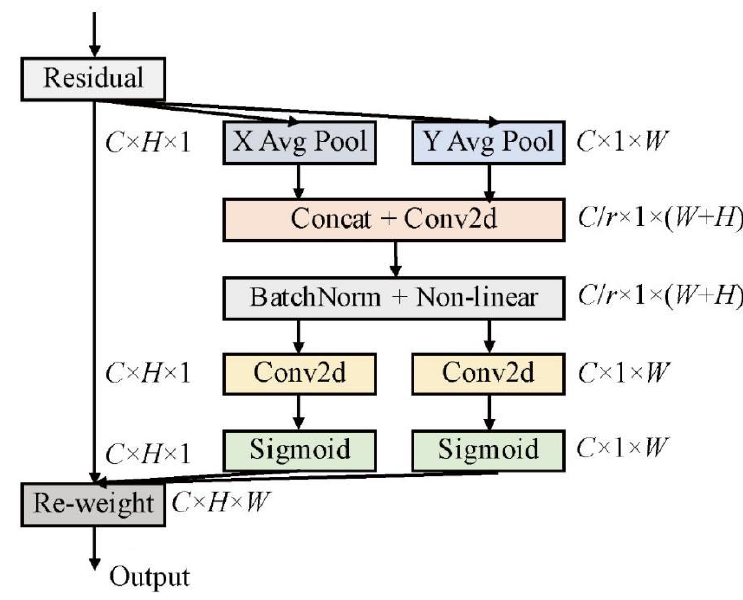
Figure 5. CA Mechanism Schematic.